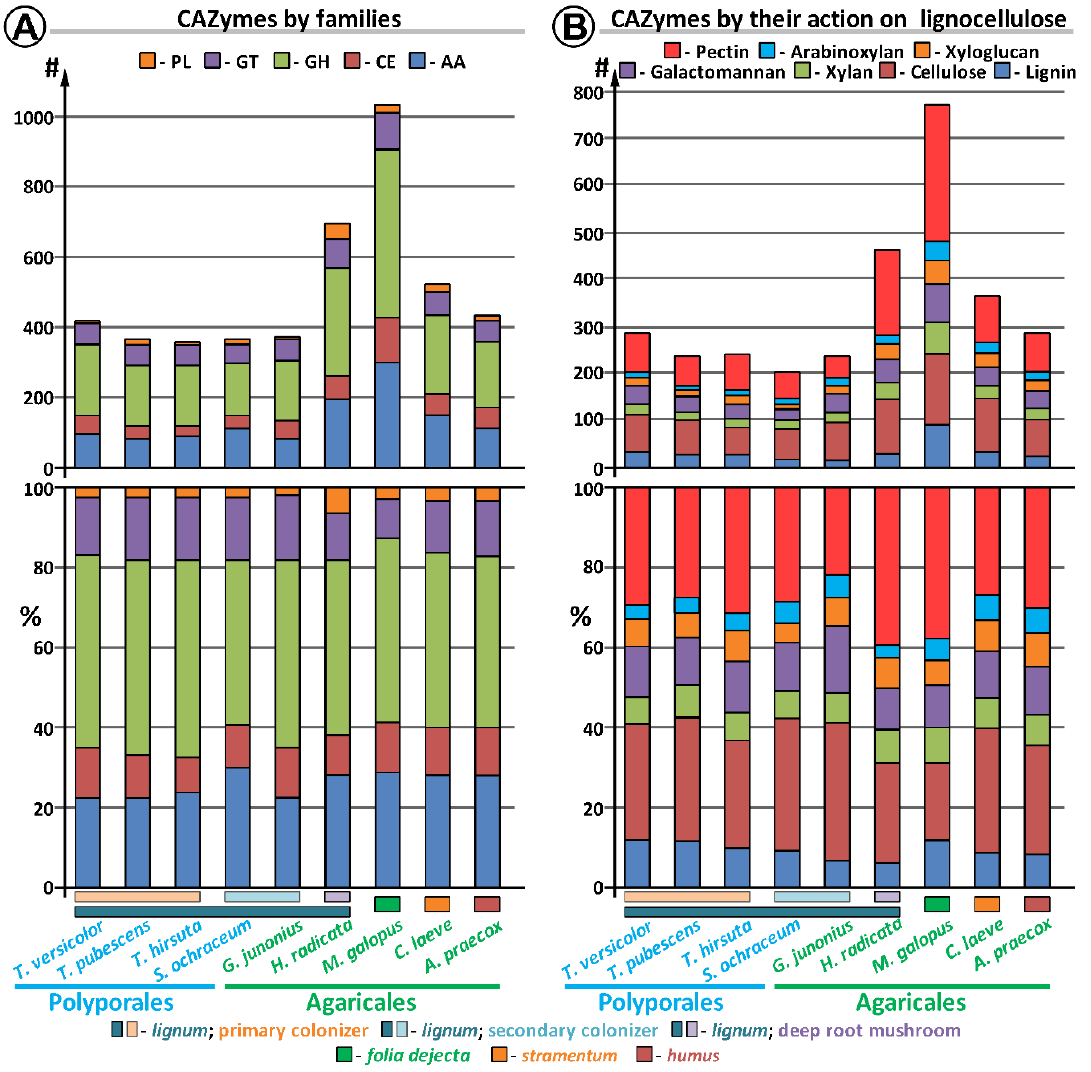
Figure 2. Comparison of the CAZyme repertoire in S. ochraceum and other fungal genomes.